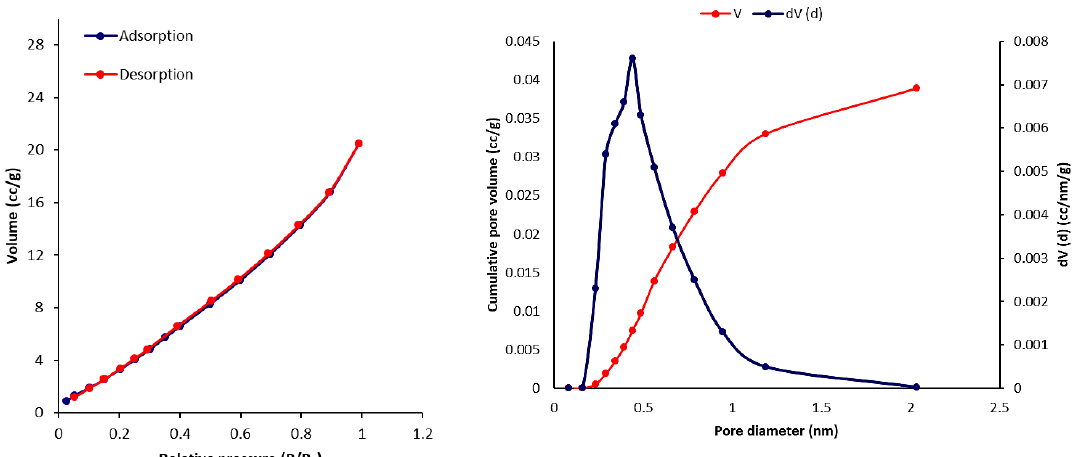
Figure 5. Adsorption–desorption isotherms of N 2 and pore size distribution curve for 6 .